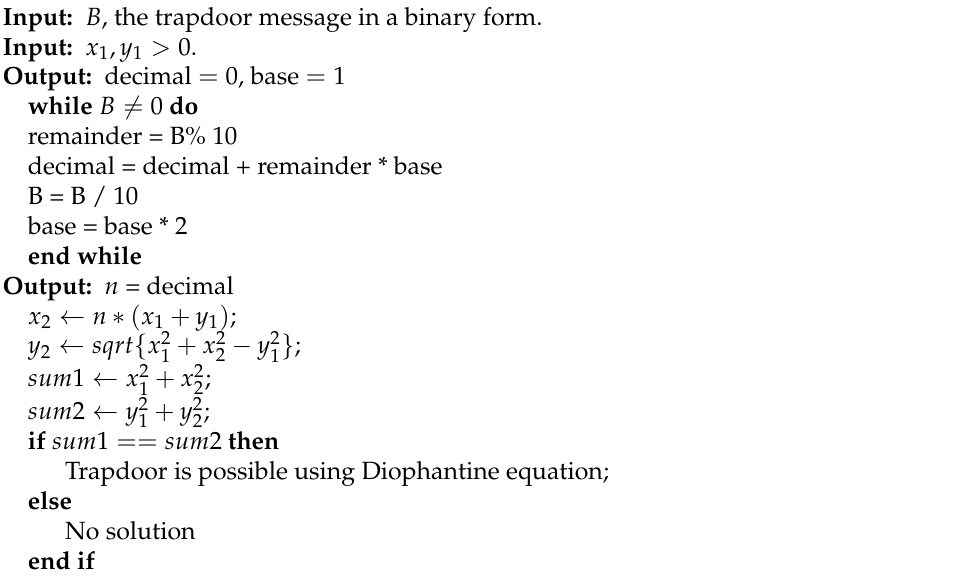
Algorithm 1 Pseudocode for the authentication